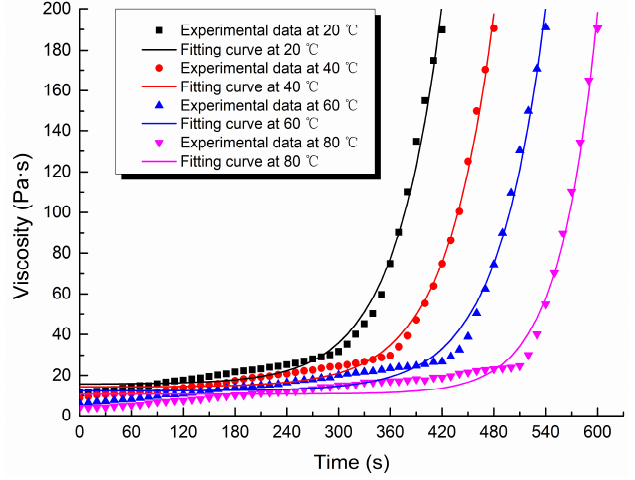
Figure 12. Fitting curves of viscosity of the HGTGS.